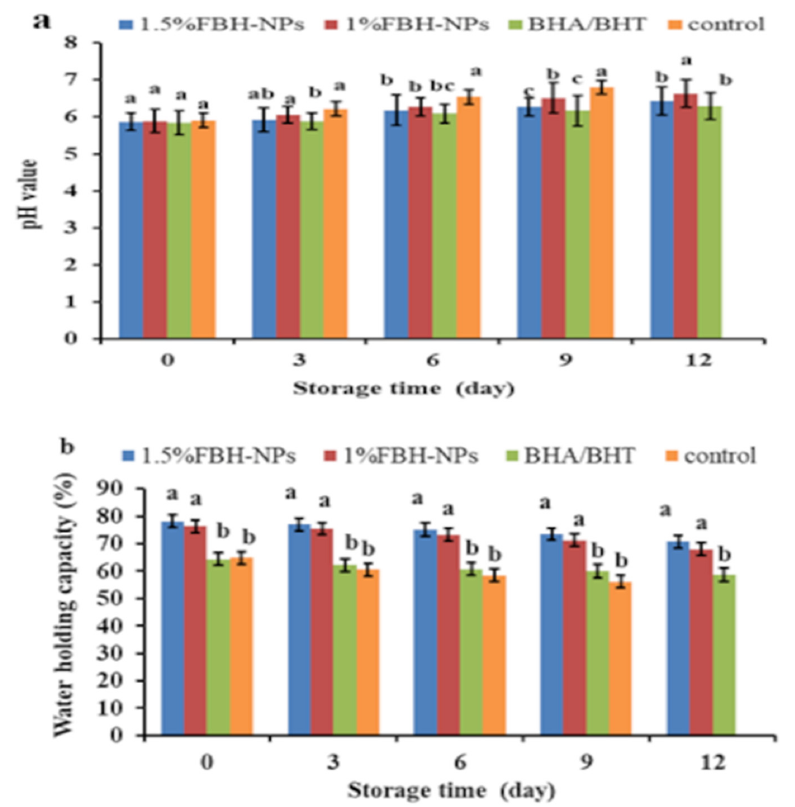
Figure 1. Changes in pH ( a ) and WHC ( b ) values of burgers incorporated with FBH-NPs and BHA/BHT during storage at 4 ± 1 °C. Error bars represent standard deviation, ( n = 3). Different superscripts (a–c) lowercase letters indicate significant differences at p < 0.05 between treatments at each storage time.